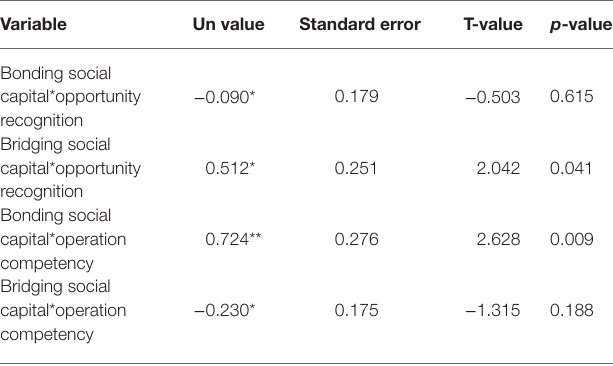
TABLE 6 | Analysis of the moderation